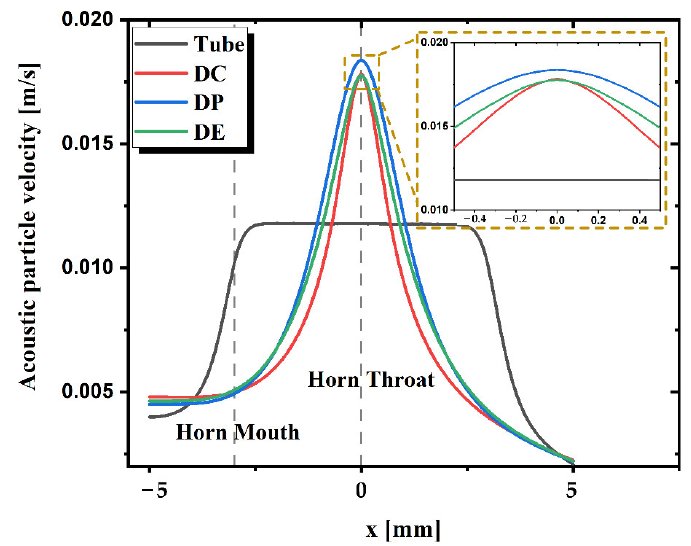
Figure 4. Acoustic particle velocity distribution along the x -axis of the tube horn, DC horn, DP horn, and DE horn. The inset shows the velocity around the horn throat.